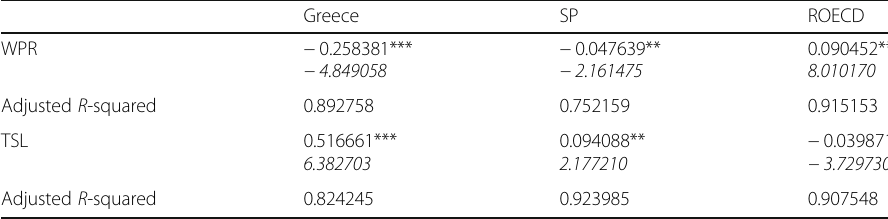
Table 9 TFP vs WPR and